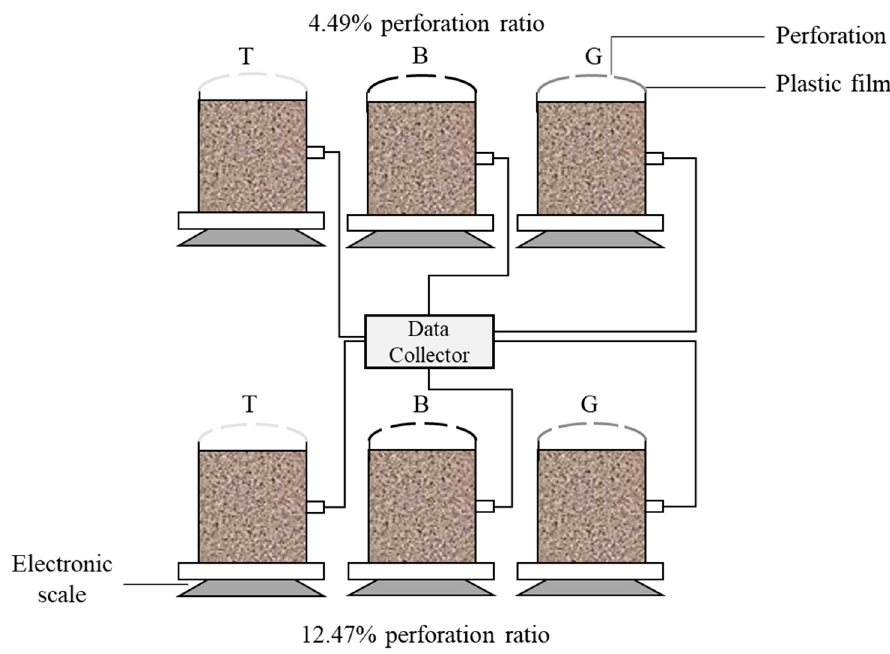
Figure 1. Schematic diagram of the column experimental setup. Table 1. Particle size distribution and texture of soil used in the study.